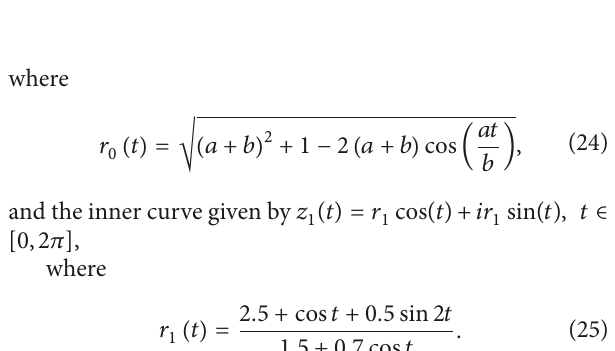
Figure 2: The domain in Example 2.